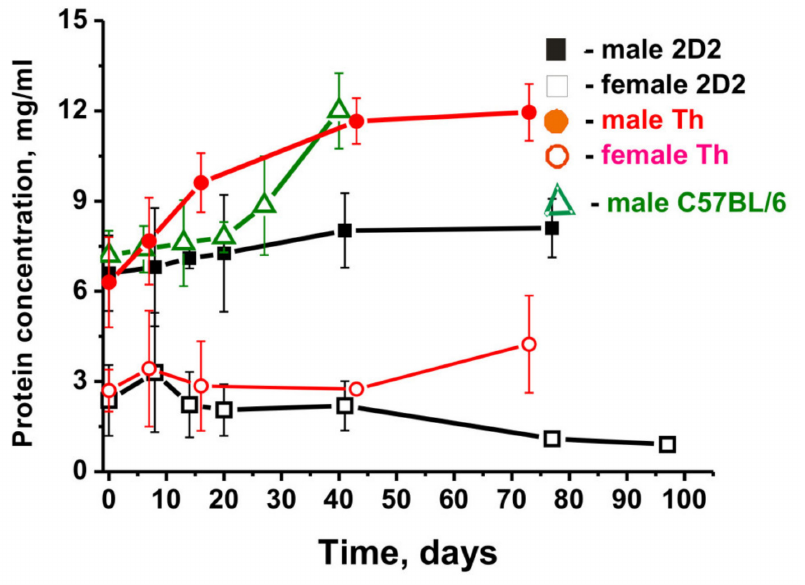
Figure 1. Relative changes in proteinuria during time-related development of EAE by 2D2 (black symbols), Th (red symbols) male and female, and C57BL/6 (green symbols) male mice. For com- parison, the C57BL/6 [34–37] and Th [38,39] mice data were taken from our previously published articles. The duration of the experiment and the time of blood sampling for different strains of mice were